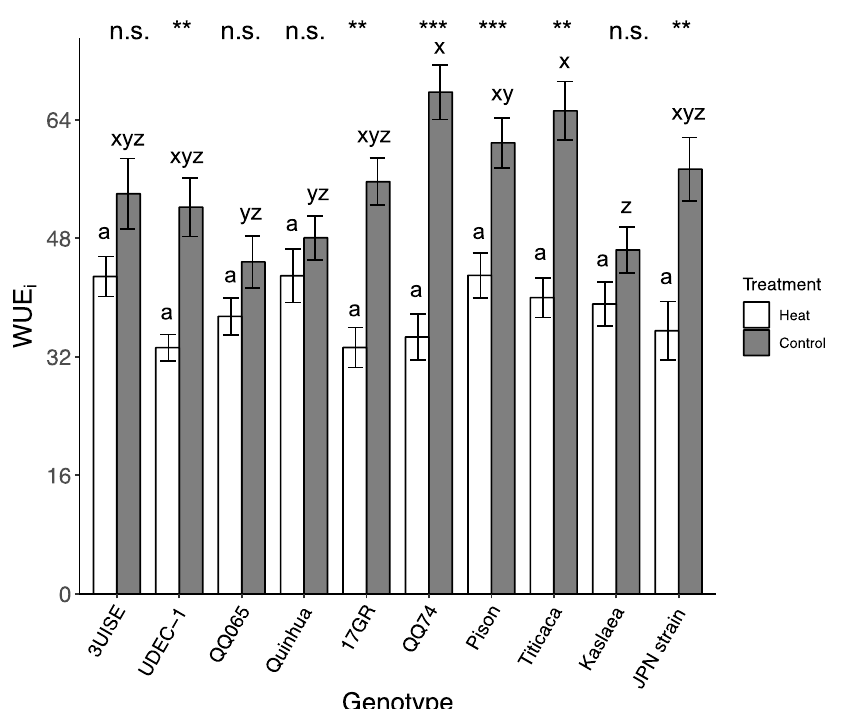
Figure 3. Intrinsic water use efficiency (WUE i ; calculated as P n /g s ) of 10 quinoa genotypes exposed to a four-day heat treatment (45 °C/30 °C) and control treatment (20 °C/14 °C); day and night, respectively. Values are means ± SE ( n = 23–32). Mean comparisons are shown for within genotype (asterisks and n.s.) and within temperature treatment (Heat: a; Control: x to z); different letters are significantly different at p < 0.05; *, p < 0.05; **, p < 0.01; ***, p < 0.001; n.s., not significantly different.